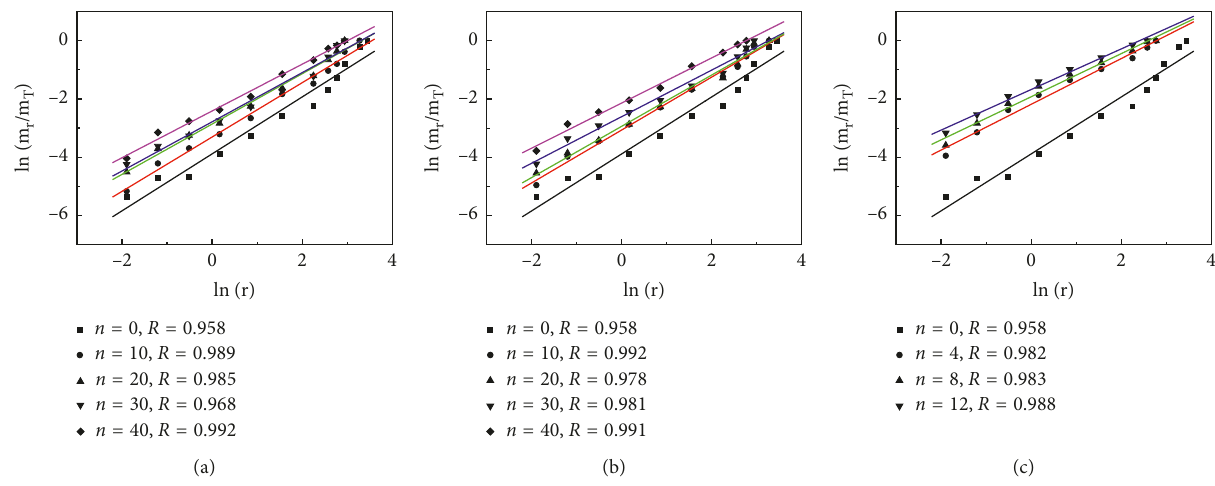
Figure 13: b value of mass fractal dimension of fragmentation: (a) L-T group, (b) M-T group, and (c) H-T